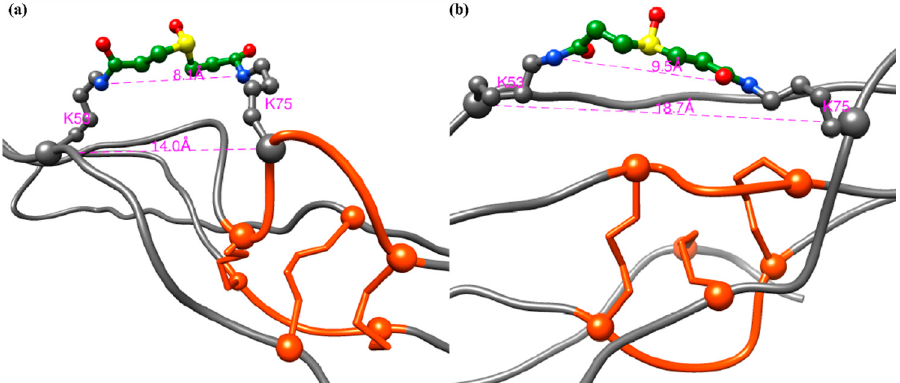
Figure 7. Ribbon diagram of CRP1 models cross-linked between K53 and K75 with DSSO, ( a ) model 1 and ( b ) model 2. The cysteines involved in cystine knots are shown as orange-red circles, and the C α carbons are represented as spheres. Cross-linked K53 and K75 are shown in grey ball-and-stick representation. DSSO cross-linkers are shown in ball-and stick representation, where nitrogen atoms are in blue, carbon atoms are in green, oxygens are in red, and sulfurs are in yellow. The distance measurements (in Å) between C α –C α and N–N atoms of K53 and K75 residues are shown in magenta.